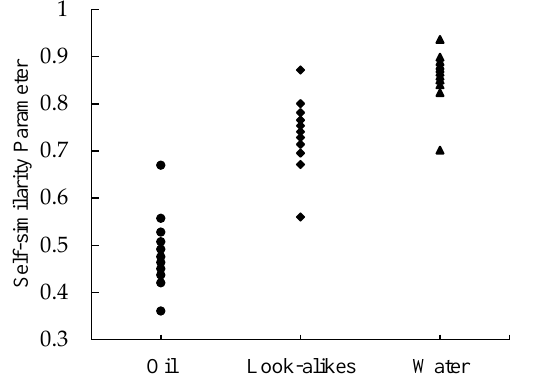
Figure. 1. The value distribution of rrr s in the oil slicks, look- alikes, and water. Table 1. The details of the three experiment images.